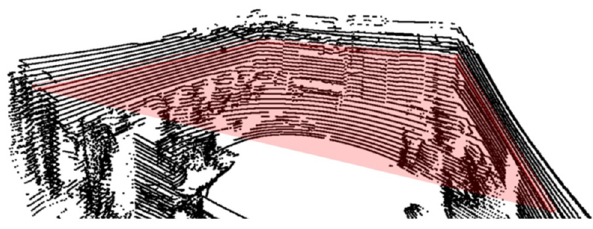
Figure 9. Error in the plane detection result of the parallel three-dimensional Hough transform